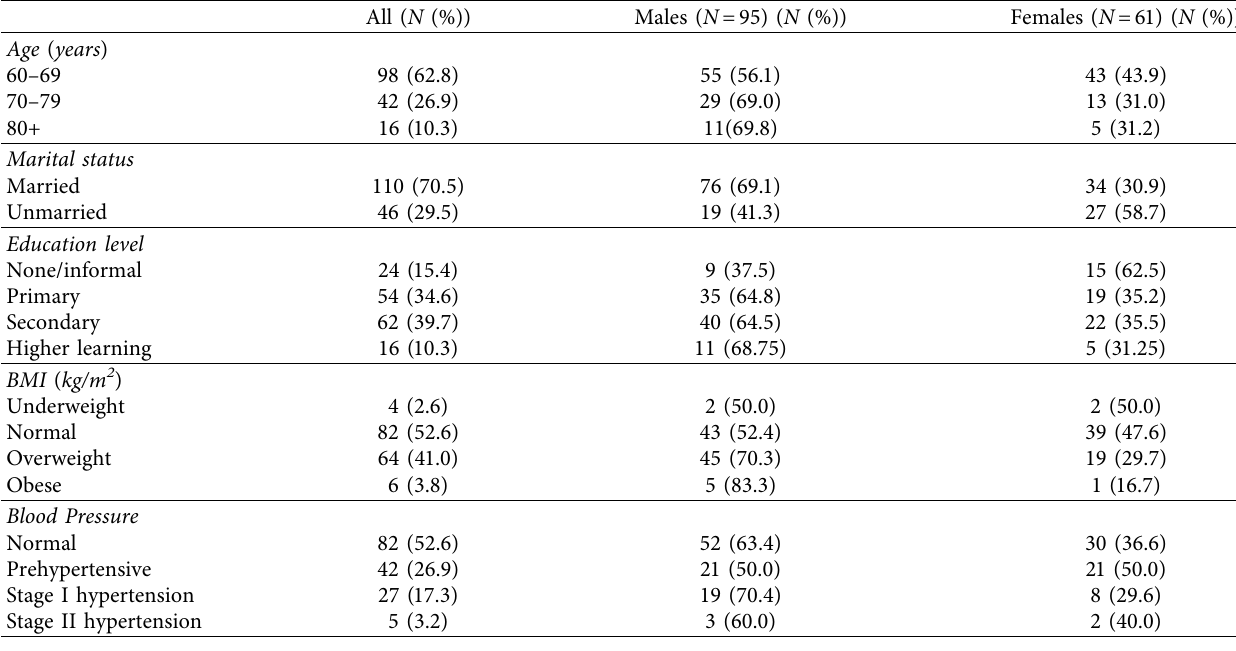
Table 1: Description of study participants.